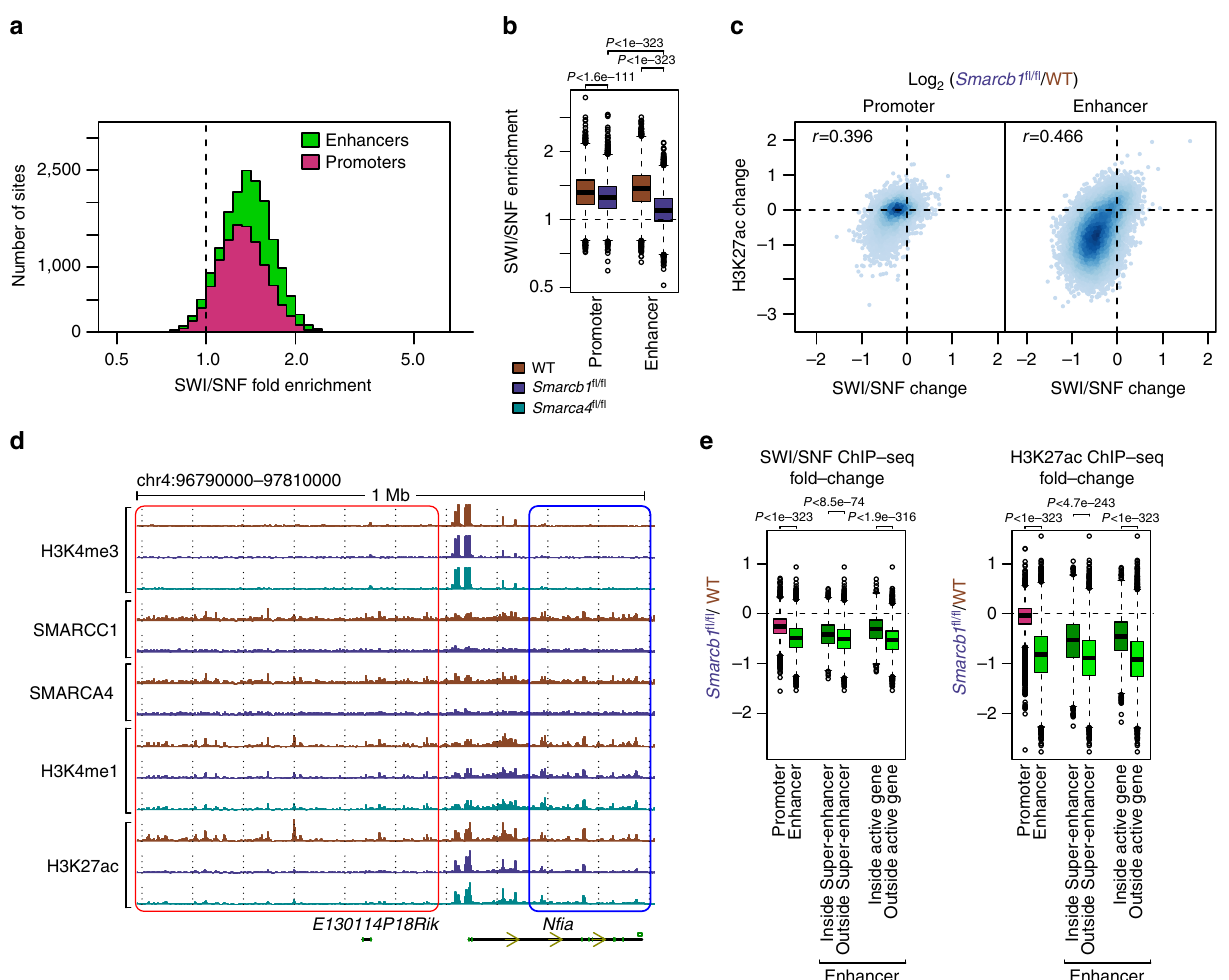
Figure 2 | SWI/SNF binds most cis -regulatory elements in wild-type but typical enhancers are most sensitive to loss of SWI/SNF subunits. ( a ) Histogram of average SMARCA4 and SMARCC1 (SWI/SNF) ChIP-seq enrichment over input at promoters and enhancers in wild-type MEFs. ( b ) Boxplots for SWI/SNF ChIP-seq enrichment over input at promoters and enhancers in wild-type and Smarcb1 -deficient MEFs. The boxes indicate first, second and third quartiles, and whiskers show 1.5 (cid:2) interquartile range below and above the first and third quartile, respectively. Two sided t -test P values are shown. ( c ). Fold changes of H3K27ac versus SWI/SNF ChIP-seq signal at promoters and enhancers in Smarcb1 -deficient relative to wild-type MEFs. ( d ) Representative screenshot depicting clusters of enhancers with different sensitivities to Smarcb1 or Smarca4 loss (red highlights high sensitivity, blue highlights low sensitivity). ( e ). Boxplots for SWI/SNF and H3K27ac signal fold changes upon Smarcb1 loss at promoters, enhancers, and enhancers classified based on super-enhancers (SE) and transcription (PolII enrichment). The boxes indicate first, second and third quartiles, and whiskers show 1.5 (cid:2) interquartile range below and above the first and third quartile respectively. Two sided t -test P values are